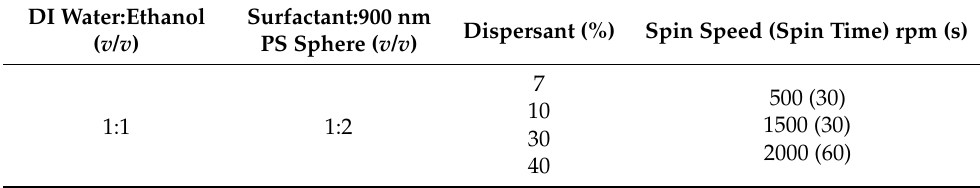
Table 2. The processing parameters used for self-assembly of 900 nm